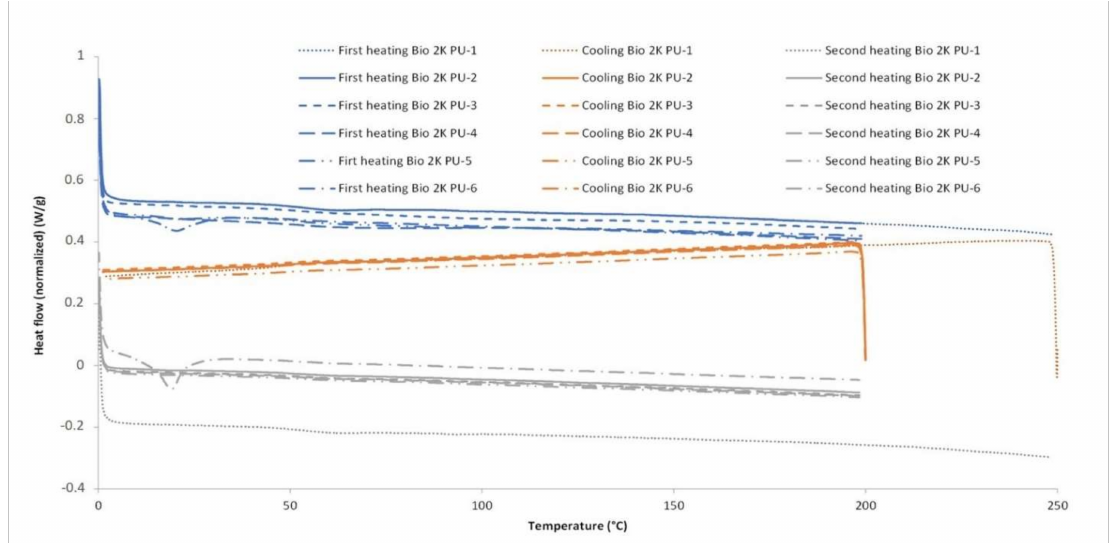
Figure 9. DSC curve of all the Bio 2K PU